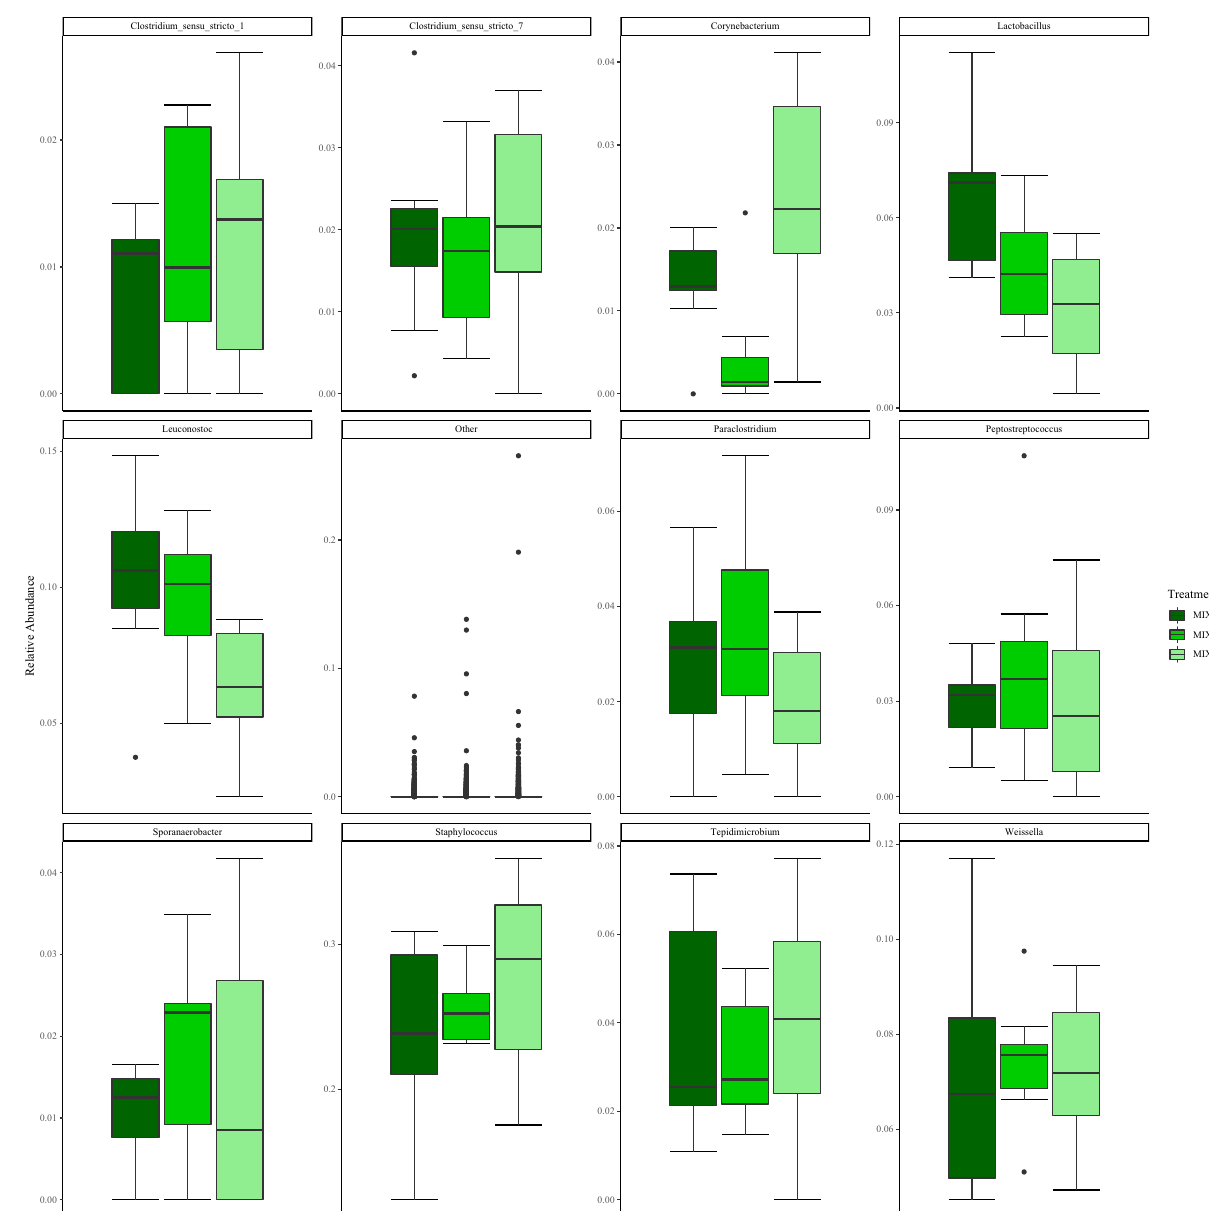
Figure 7. Boxplots of gut bacterial composition using relative abundance of the most common genera for MIX